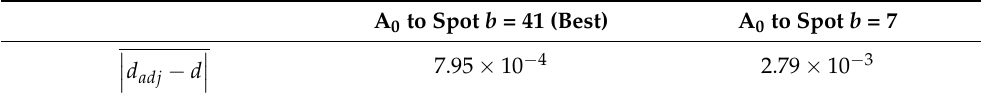
Table 3. Mean of differences between the feed horns locations adjusted and original locations for both A 0 to the spots 41 and 7.